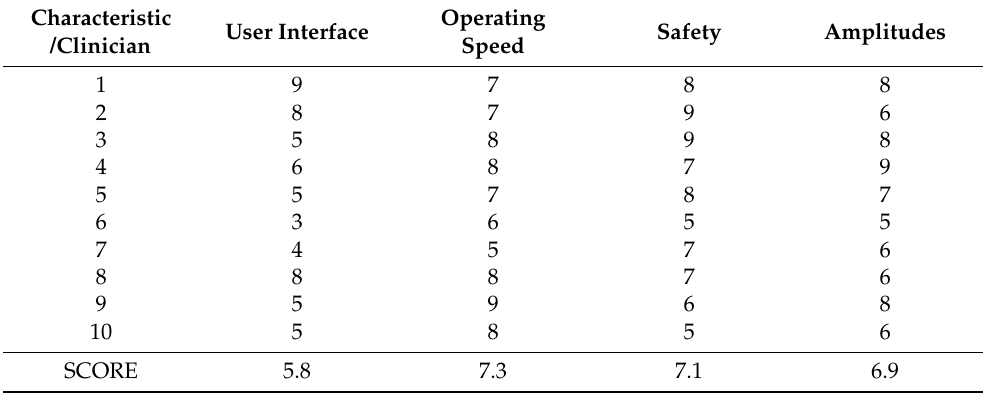
Table 5. Marks given by the clinicians.